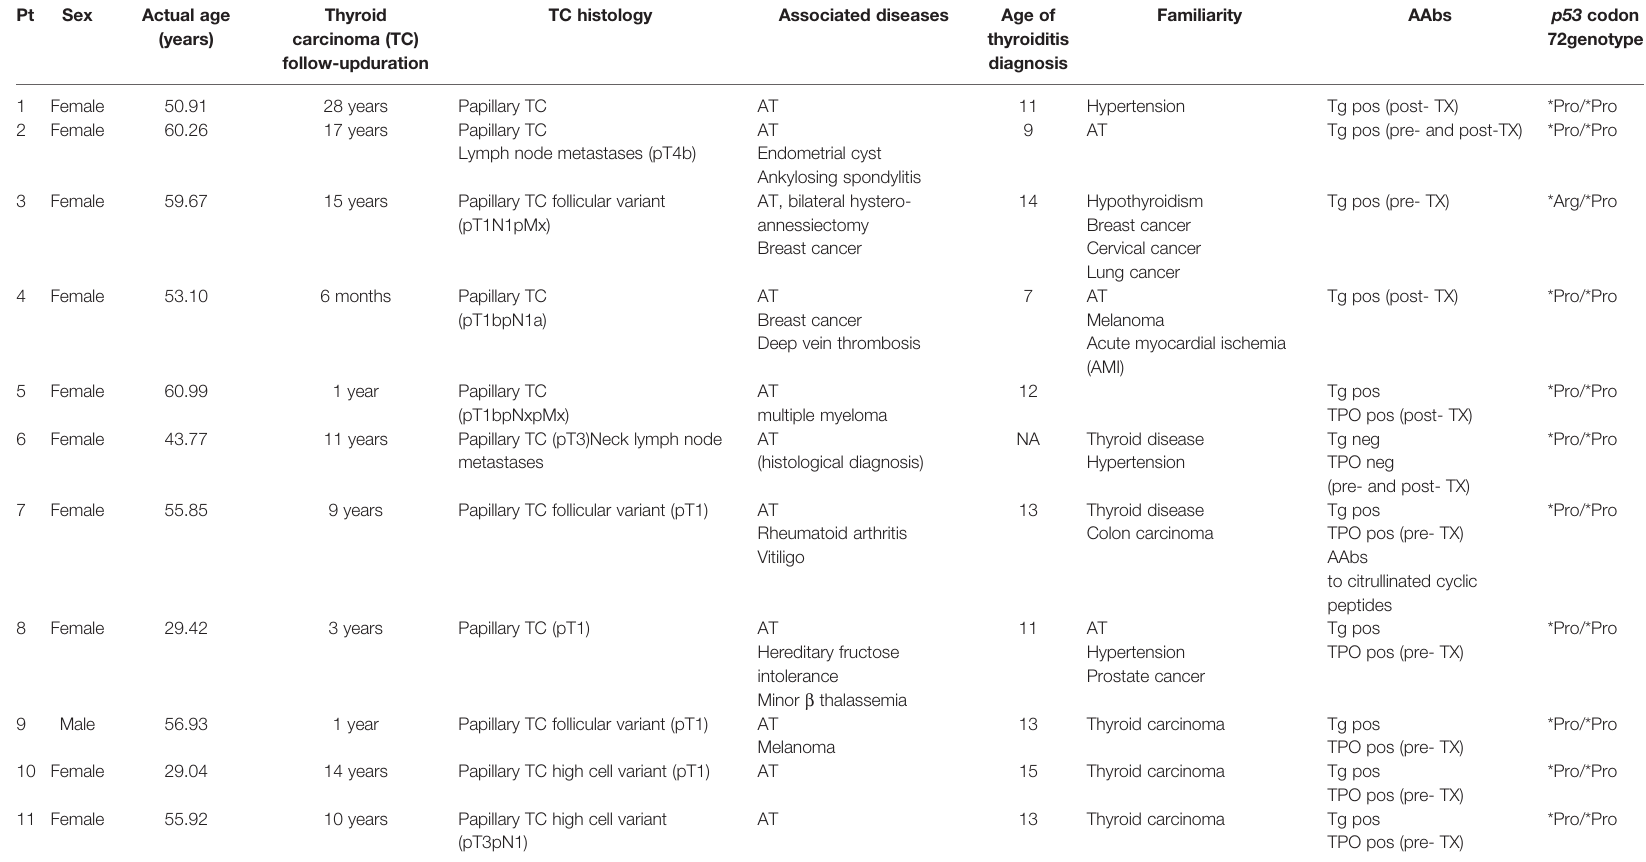
TABLE 1 | Demographic, clinical characteristics, and thyroid autoantibody levels in patients with thyroid carcinoma recruited for the